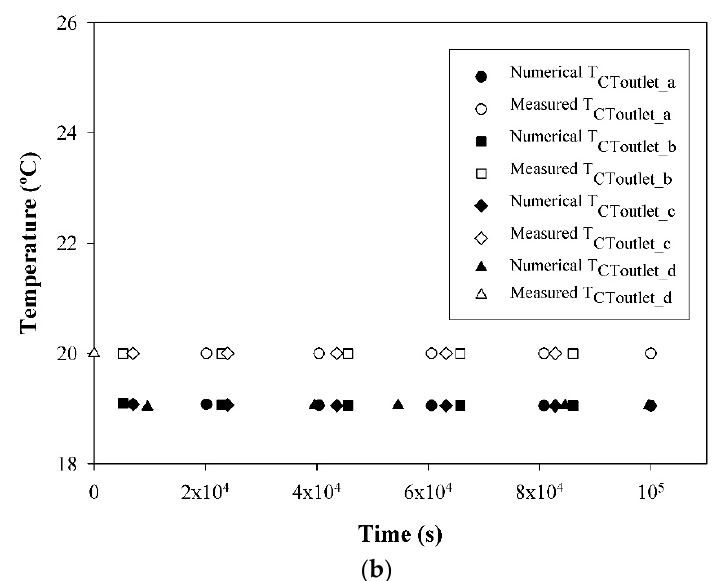
Energies 2019 , 12 , x FOR PEER REVIEW Figure 4. Water temperature at cooling tower ( a ) inlet: T CTinlet and ( b ) outlet: T CToutlet .